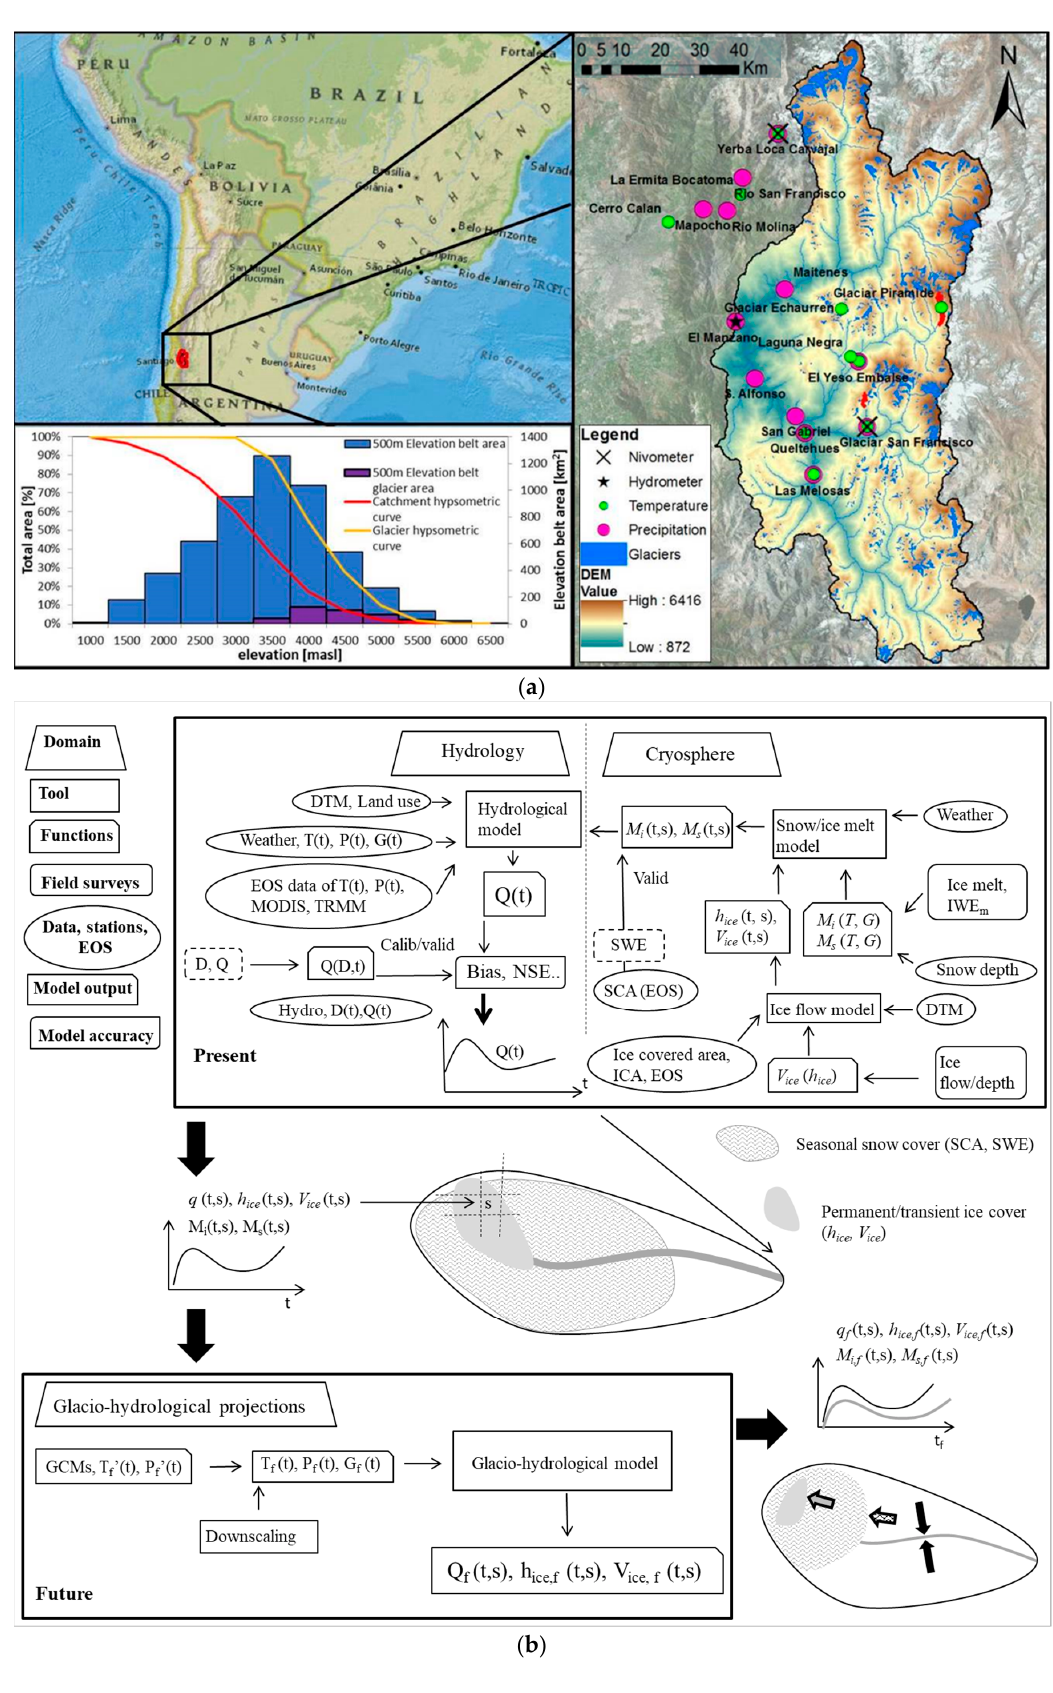
Figure 1. ( a ) Case study. Rio Maipo. Location of gauging/weather stations, glaciers, hypsometry. Field campaigns were carried out in 2012 on glaciers San Francisco and Pyramid. ( b ) Flow chart of the modelling approach and components, data requirements, tuning methods, and water